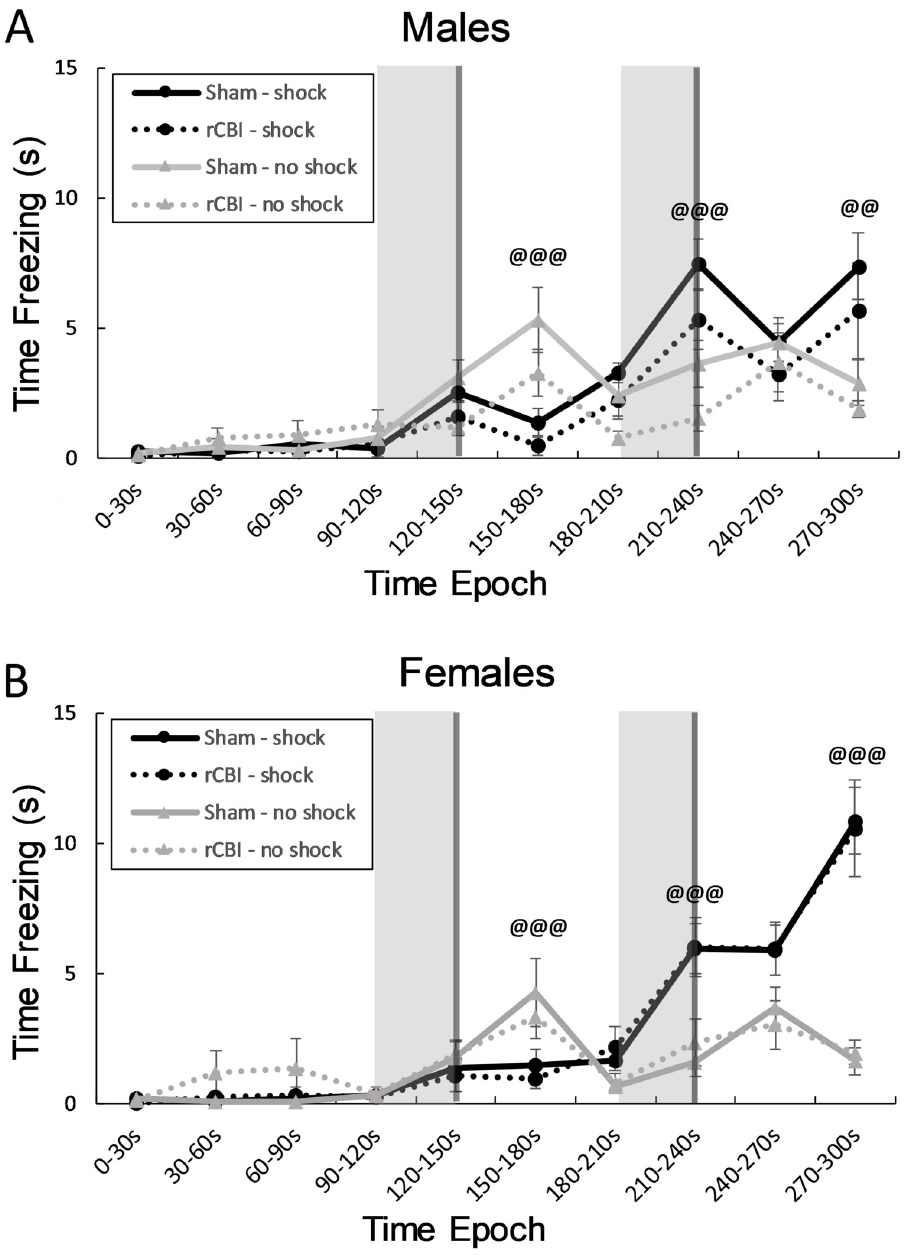
Fig 7. Freezing behavior during pairing of a neutral stimulus (tone) with an aversive stimulus (foot shock). Regions with light gray shading indicate times during which tone was presented; tones co-terminated with a 2-second foot shock (darker gray bar). During the 30-second time period following the first tone (150-180s), shocked mice froze less than unshocked controls (@@@; A & B , Unshocked > Shocked, p < 0.0001). However, during the second tone (210-240s) and during the last time period (270-300s), shocked mice displayed more freezing behavior than mice that did not receive foot shocked paired with the tones (@@@, Shocked > Unshocked, p < 0.0001, @@, Shocked > Unshocked, p < 0.01). rCBI, repetitive concussive brain injury.